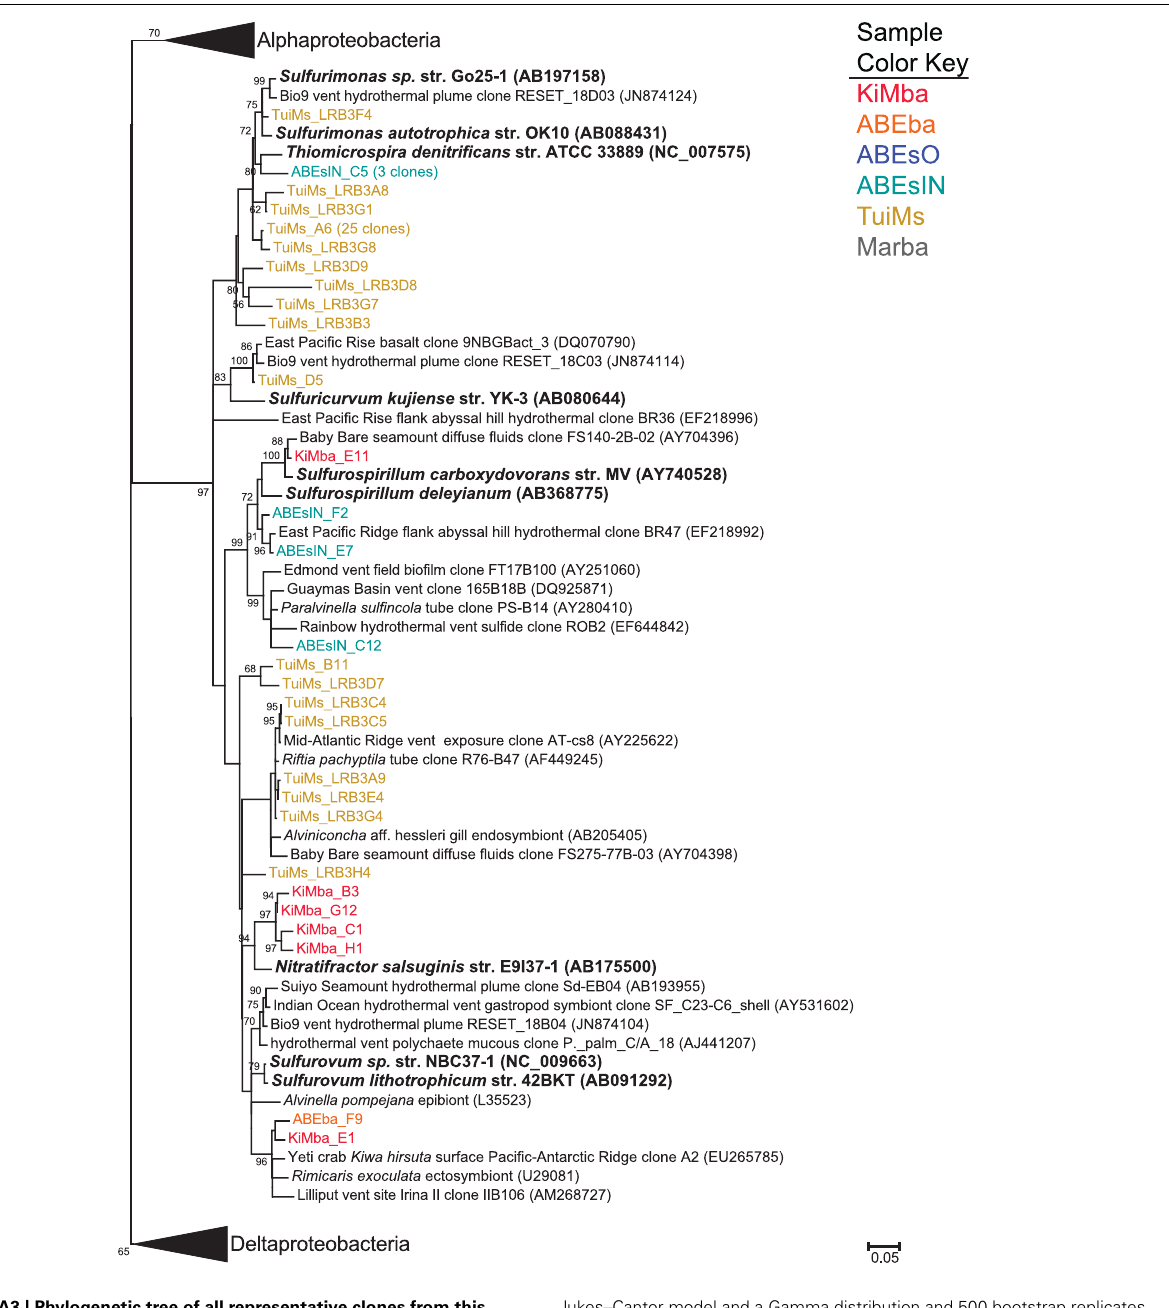
FIGUREA3 | Phylogenetic tree of all representative clones from this study that fall within the ε -Proteobacteria. The tree was generated in MEGA 5 (Tamura et al., 2011) using the maximum likelihood method with the